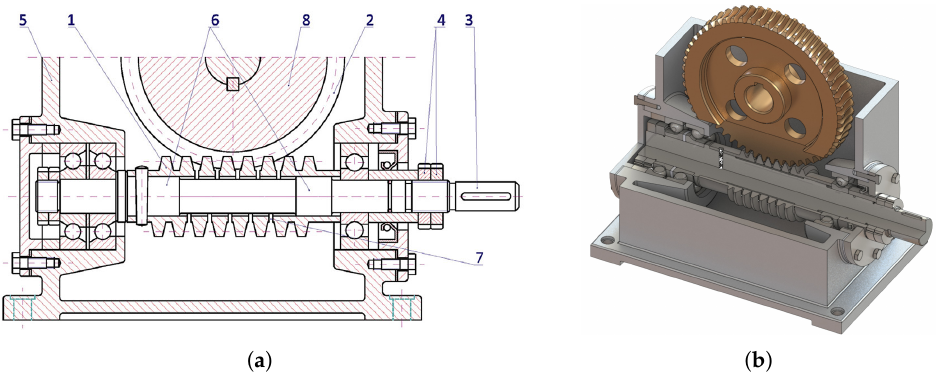
Figure 13. Worm gear drive with locally axially adaptive worm. ( a ) Worm gear drive structural design. ( b ) Worm gear drive